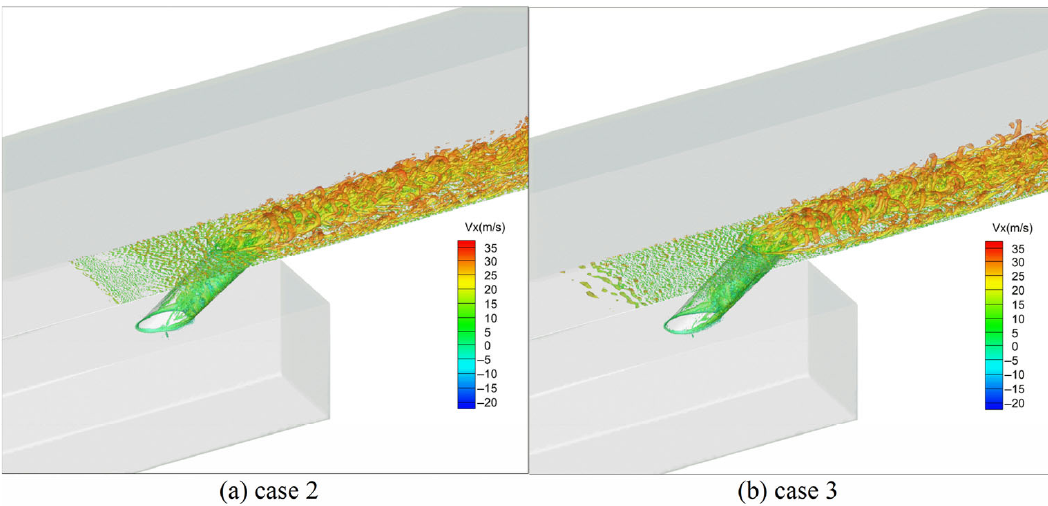
Figure 16. Comparison of vortex structures between Case 2 and Case 3.